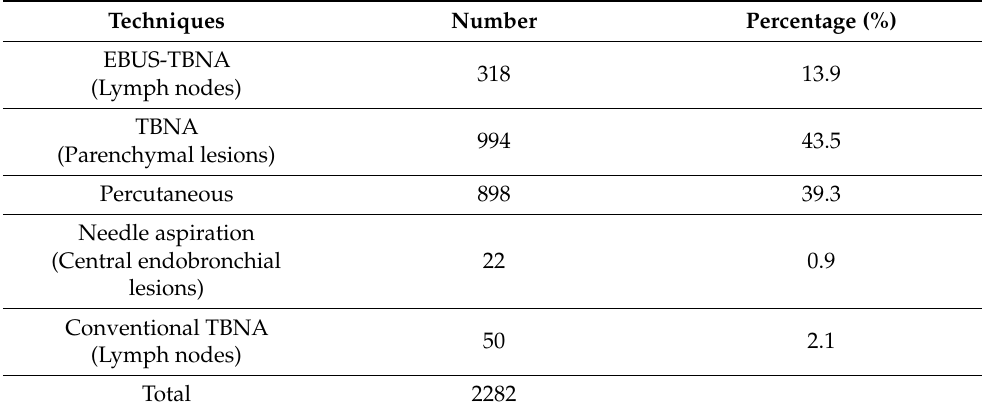
Table 1. Summary of the procedures performed with ROSE.